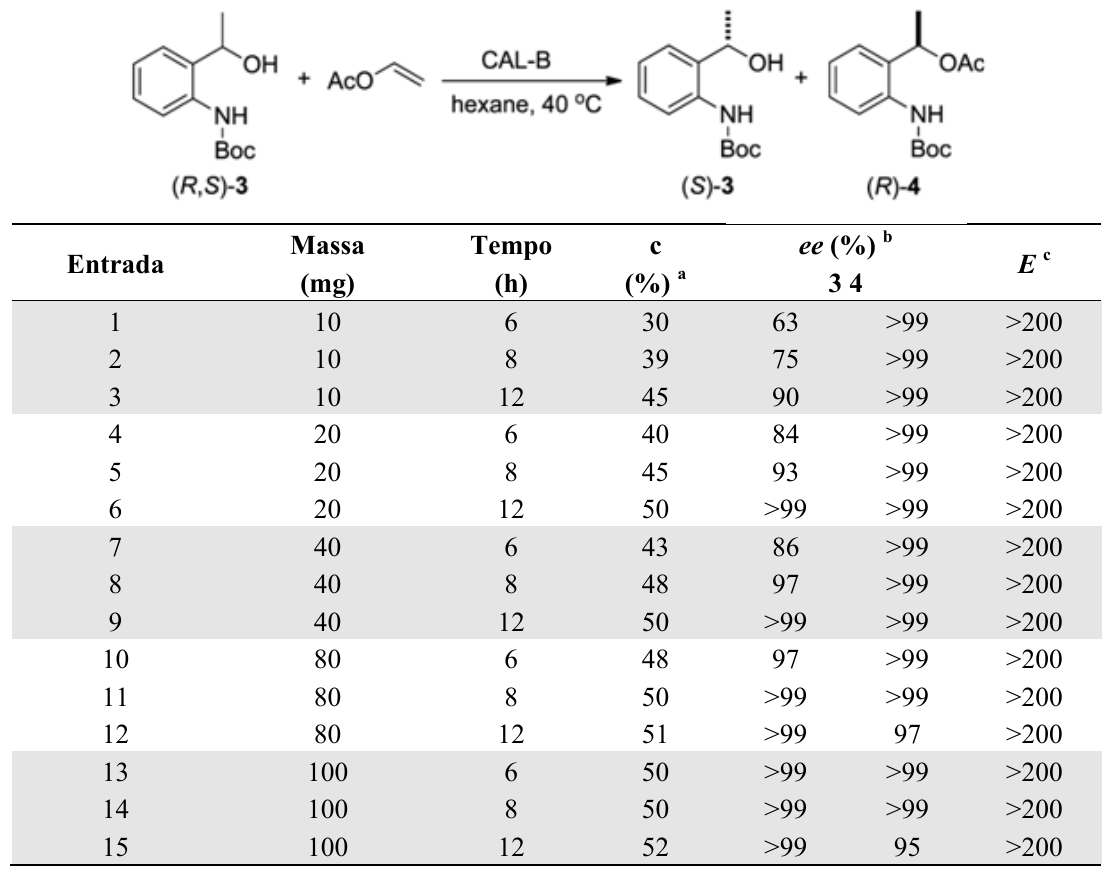
Table 5. Study of ratio CAL-B/substrate for kinetic resolution of ( R,S )- 3 .